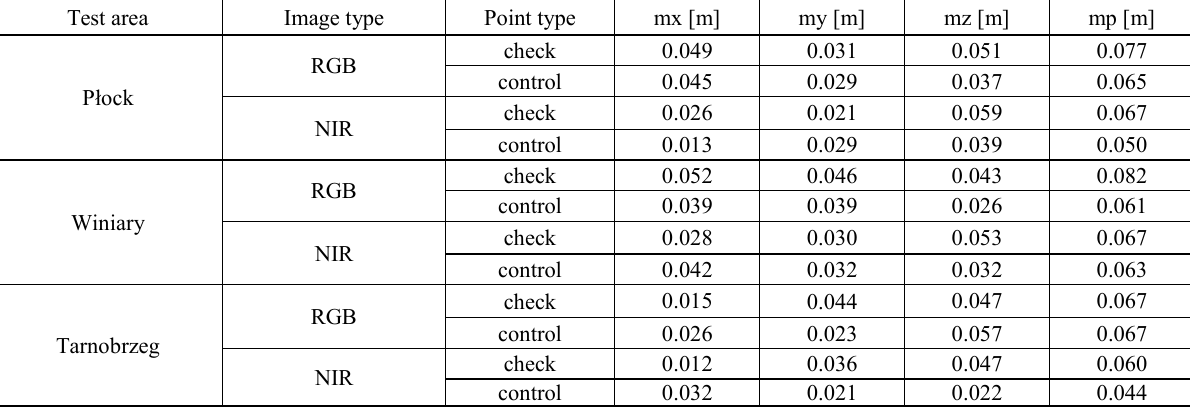
Table 5. Errors for the checkpoints and control points used for the UAV image orientation